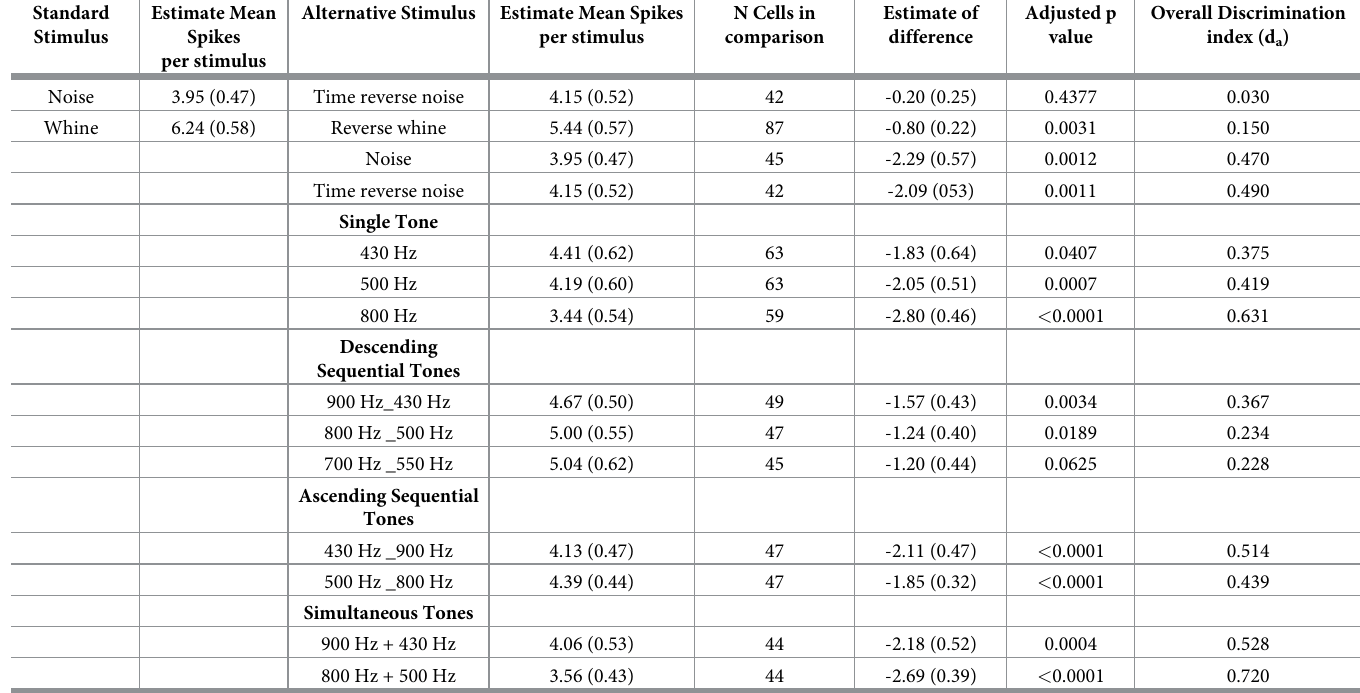
Table 1. Linear mixed model analysis of spike response to whine or noise versus experimental stimuli. Columns are: the standard stimulus (basis for comparisons) and the mean spike number (SEM); the alternative stimulus and mean spike number ( ± s.e.); number of cells in the dataset recorded for both stimuli; difference in spike number, the adjusted p value of the comparison, and the discrimination index (d a ) for the entire stimulus response. Graphic representation of the within-cell comparisons are in Fig 6. Standard Estimate Mean Stimulus